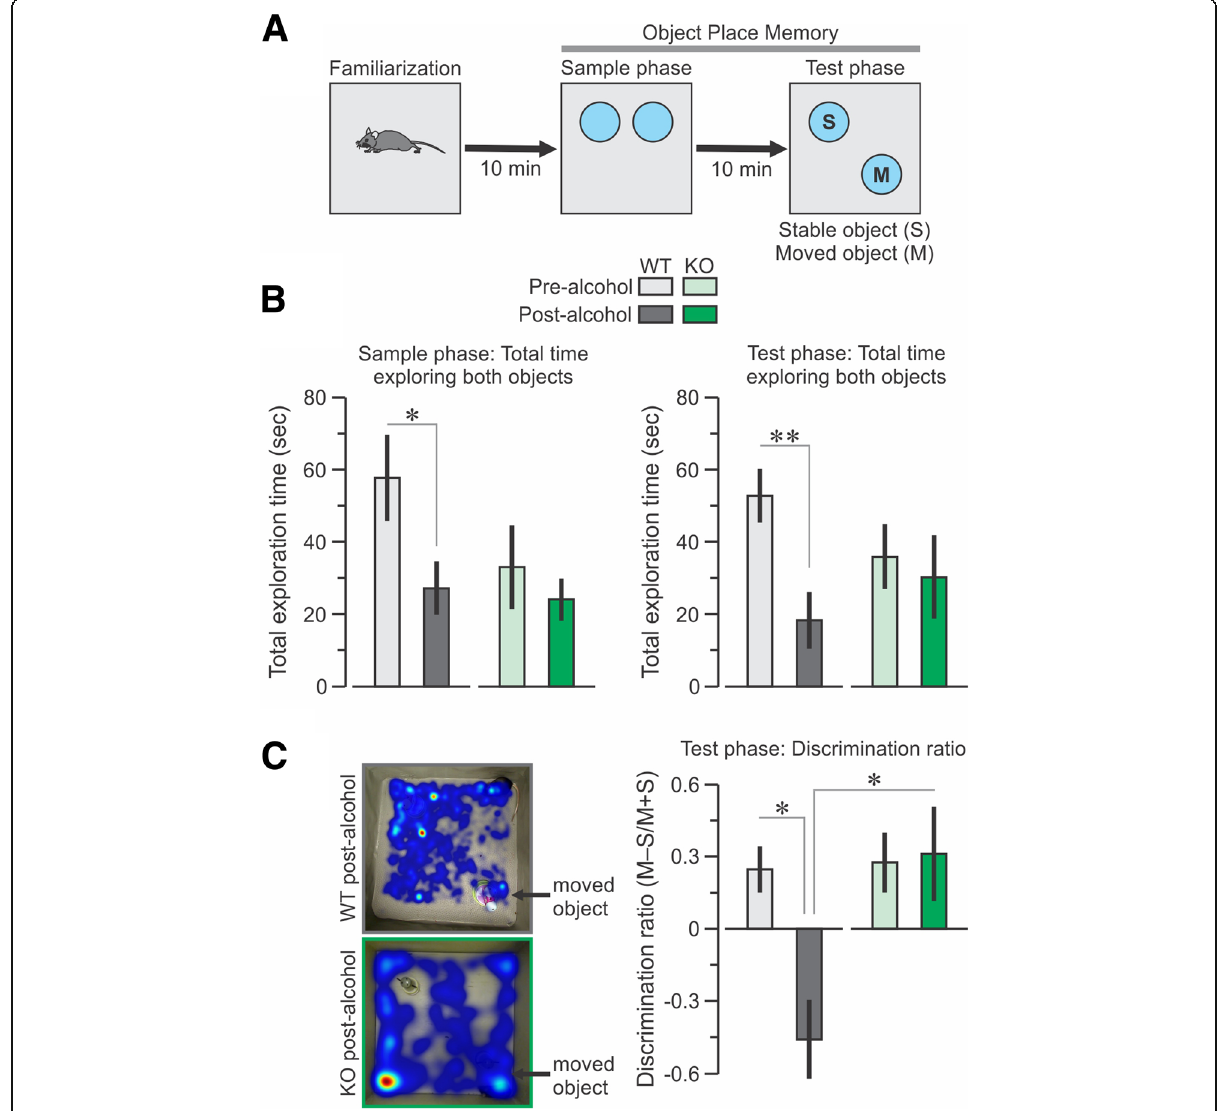
Fig. 3 Deficiency in CIRP prevented the decreased spatial cognition observed in the WT mice after binge alcohol. a Scheme for the object-place memory (OPM) task in which a mouse explores two objects, with one object being moved in the last session. b Total time exploring both objects during sample phase and test phases. c Left , representative heat maps of WT and CIRP − / − mice exploring the moved object, Right , discrimination ratio (moved minus stable object over moved plus stable object [(M-S)/(M + S)]) between WT and CIRP − / − mice at pre-alcohol and post-alcohol conditions. Data are expressed as mean ± SE; * P < 0.05; ** P < 0.005 by